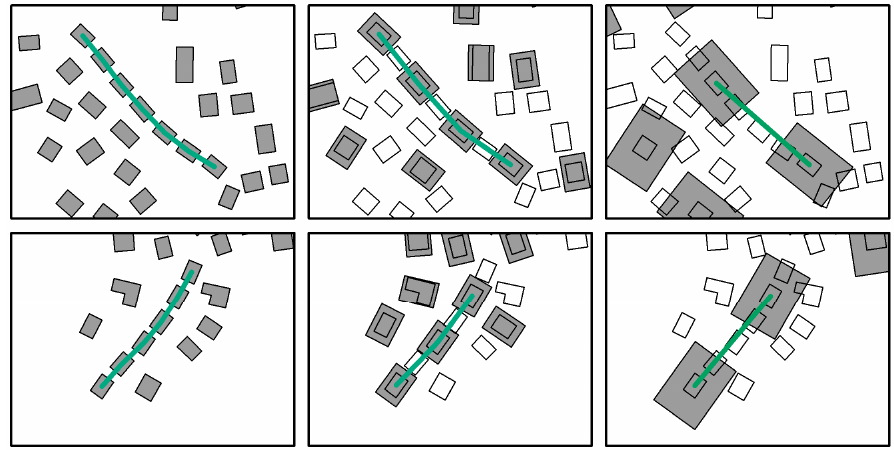
Figure 24. Two alignments of selection unit A in detail. The pictures on the left are building alignments at the source map scale, the pictures in the middle are building alignments at 1:25,000, and the pictures on the right are building alignments at 1:50,000 (outlined shapes: original buildings, fully shaded shapes: selected buildings).